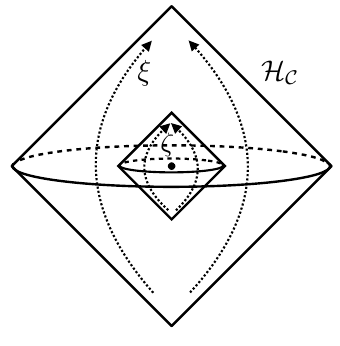
Figure 3: A causal diamond in the de Sitter space static patch. The conformal Killing vector ζ turns into the timelike Killing vector ξ if the boundary of the diamond coincides with the cosmological horizon H C